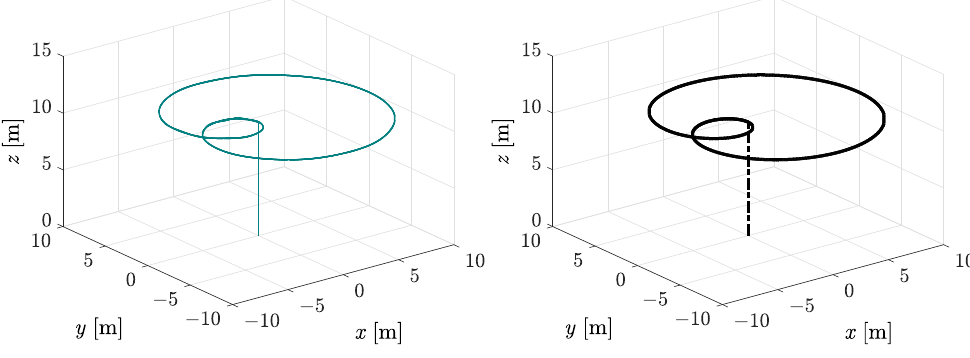
Figure 18. Path following in the 3D